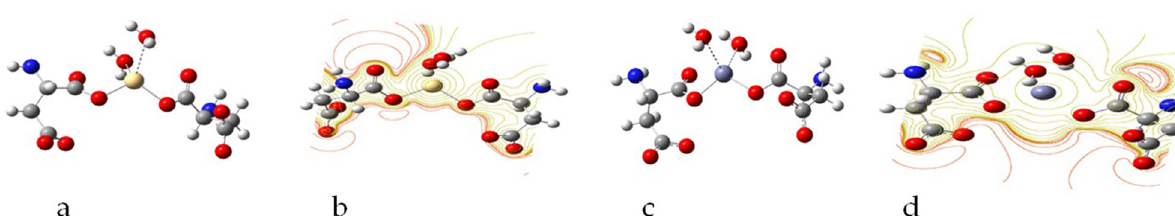
Figure 5. Model molecules for ( a ) di-hydrated cadmium interacting with two aspartic units, ( b ) ESP contour for di-hydrated cadmium interacting with two aspartic units, ( c ) di-hydrated zinc interacting with two aspartic units, ( d ) ESP contour for di-hydrated zinc interacting with two aspartic